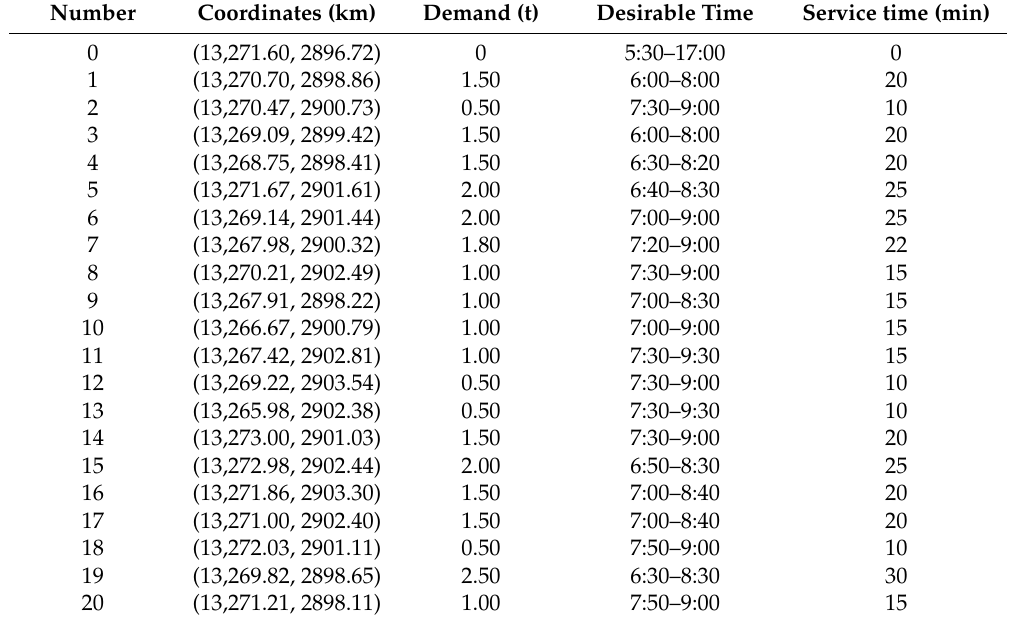
Table 3. Customer information.